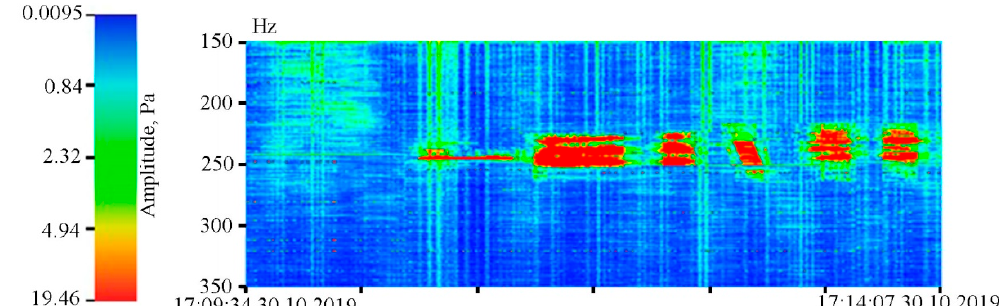
Figure 14. Dynamic spectrogram of the record of the supersensitive detector of hydrosphere pressure variations, obtained in the process of recording signals of various complexity, generated by a low-frequency hydroacoustic emitter with carrier frequency of 245 Hz.